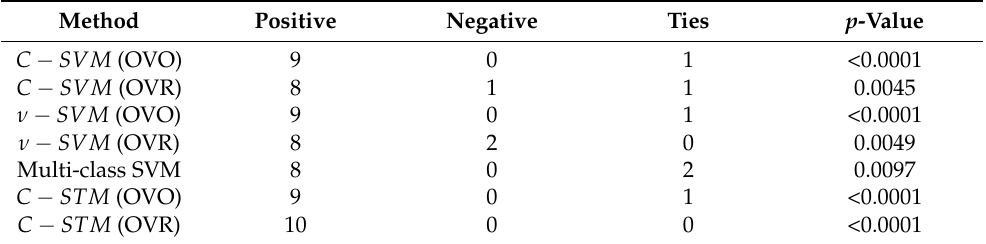
Table 7. The accuracies of different methods using the second type of normalization operation for multiscale airplanes classification using 10-fold